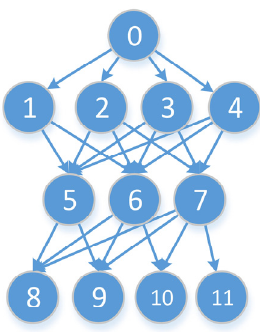
Figure 7. Regeneration Tree.